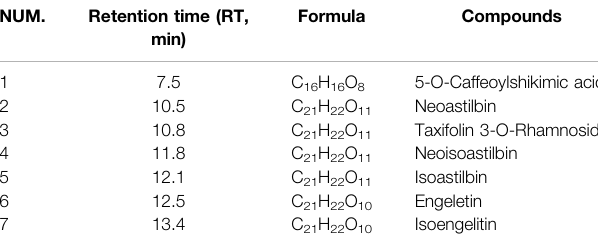
TABLE 3 | Chemical pro fi les of FZHFZY.